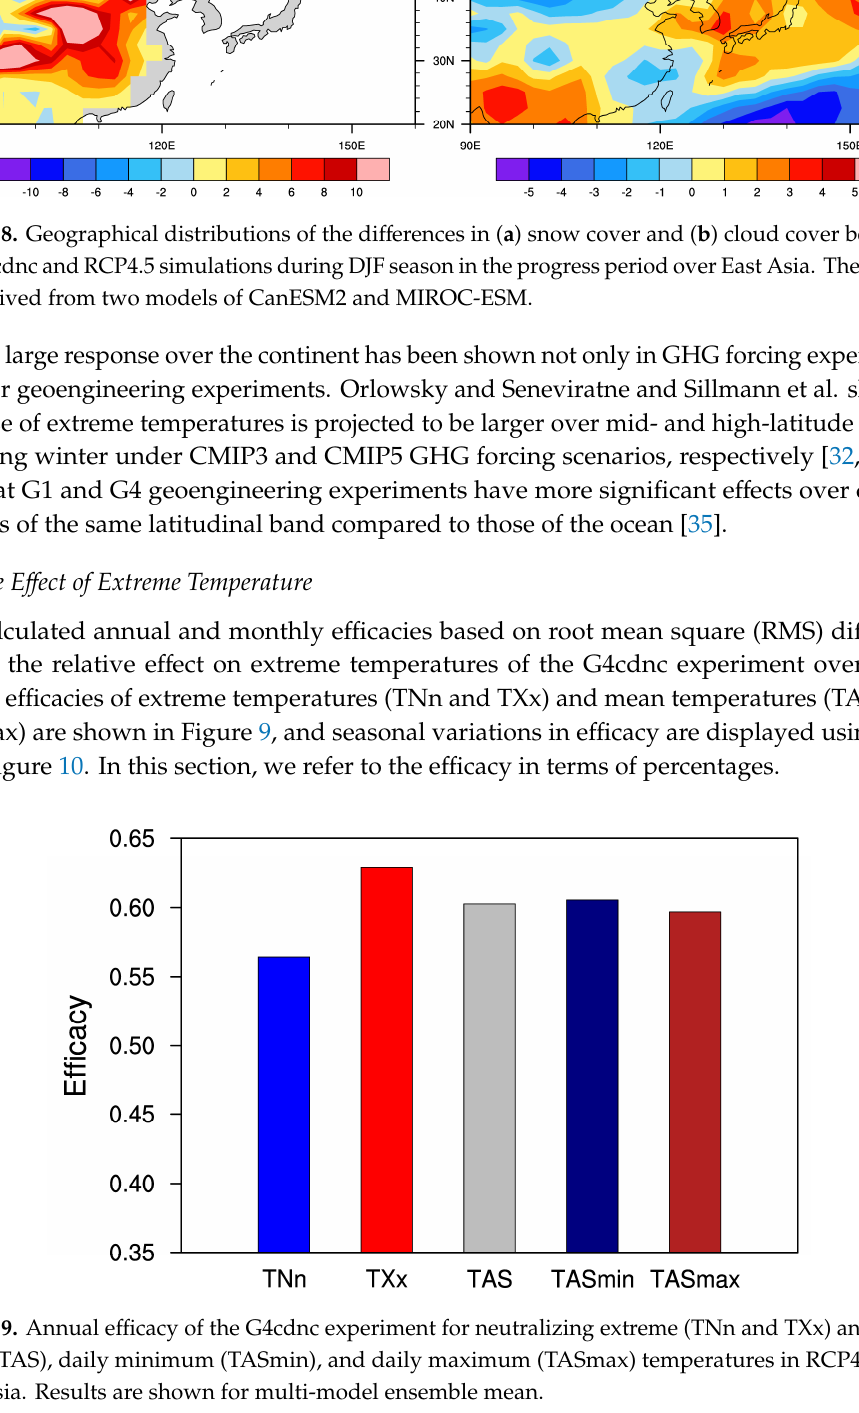
Figure 10. Timeseries of monthly efficacy of the G4cdnc experiment for neutralizing extreme (TNn and TXx) temperatures during the progress period (2060–2069) in RCP4.5 over East Asia. Results are shown for multi‐model ensemble mean. The annual efficacies of G4cdnc for decreasing the warming of TNn and TXx under the RCP4.5 conditions in the multi‐model ensemble mean over East Asia are 56.6% and 63.4%, respectively. In other words, the efficacy of TXx is larger than that of TNn by 7%, which implies that marine cloud brightening is a relatively effective method of alleviating the warming of TXx compared to TNn under GHG forcing. This asymmetric relative effect on extreme temperatures is the opposite to that represented by the absolute effect on extreme temperatures (∆TNn ≥ ∆TXx in Section 3.3). However, Curry et al., for G1 over the globe, showed that the difference between the efficacies of TNn and TXx is not significant (TNn: 87% and TXx: 89%) [33]. Therefore, the relative effect of marine cloud brightening over East Asia has a different asymmetry from that reported by the G1 experiment. Meanwhile, the annual efficacy for mean temperature over the progress period by the G4cdnc simulation is 60.9% for TAS, 61% for TASmin, and 60.4% for TASmax, which implies that G4cndc is similarly effective in alleviating the warming of the mean temperature. In addition, the efficacies for all mean temperatures are larger than that for TNn but lower than that for TXx. The monthly efficacy was investigated for extreme temperatures during the progress period (Figure 10). The efficacy of TXx was larger than that of TNn during all the months, except from